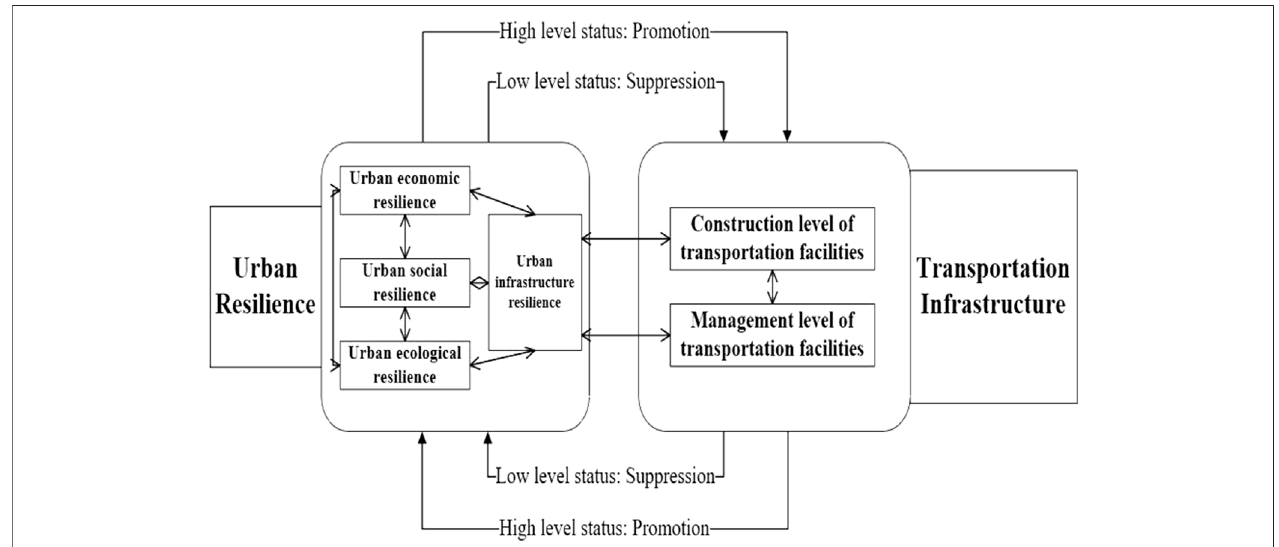
FIGURE 1 | Coupling coordination mechanism between urban resilience and the transportation infrastructure